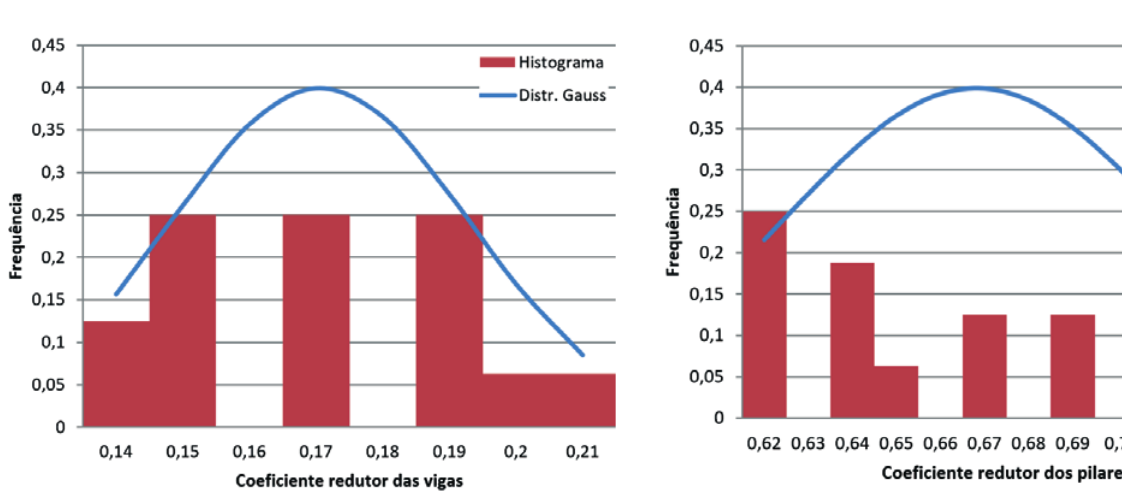
Figura 9 Distribuição de Gauss x Histrograma para a rigidez dos pilares nos exemplos com 1